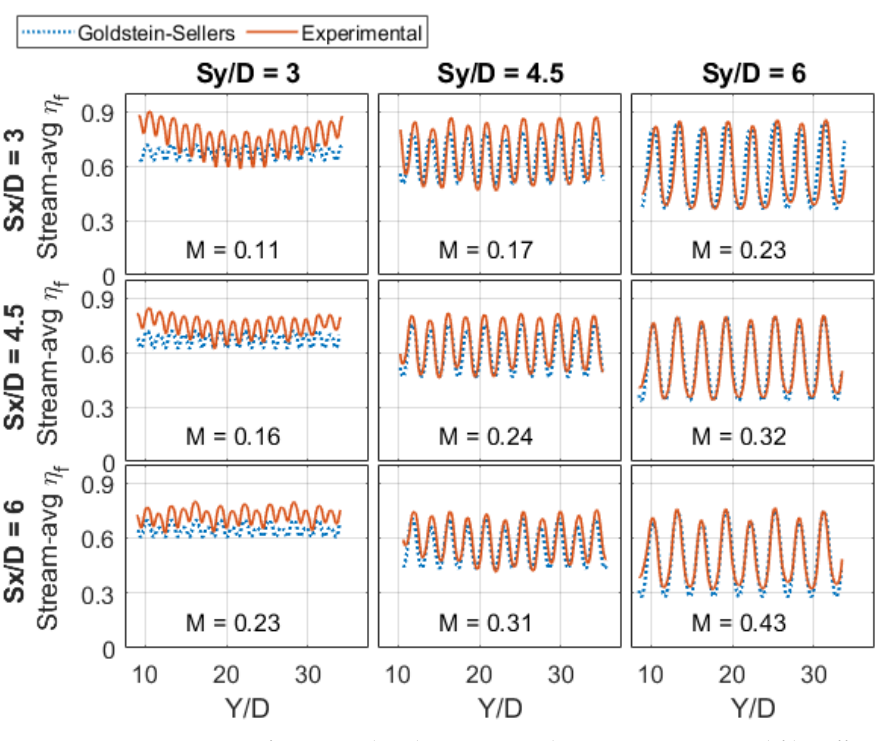
Figure 16. A comparison of numerical and experimental streamwise-averaged film effectiveness for m ∗ = 1.8.